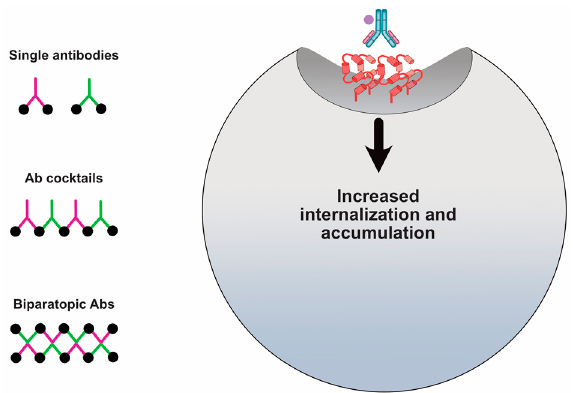
Figure 5. Schematic of di ff erent abilities to crosslink HER2 receptors, which results in increased internalization and antibody or payload cellular accumulation. Table 4. Antibody cocktail e ff ect on internalization and HER2 degradation from [49] 1